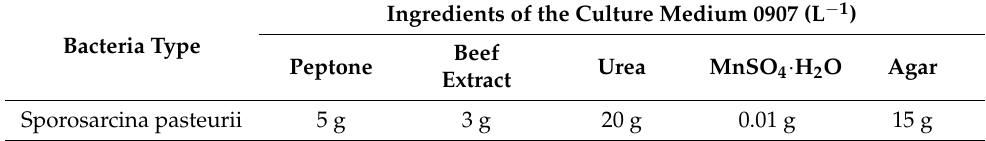
Table 1. Ingredients of culture medium